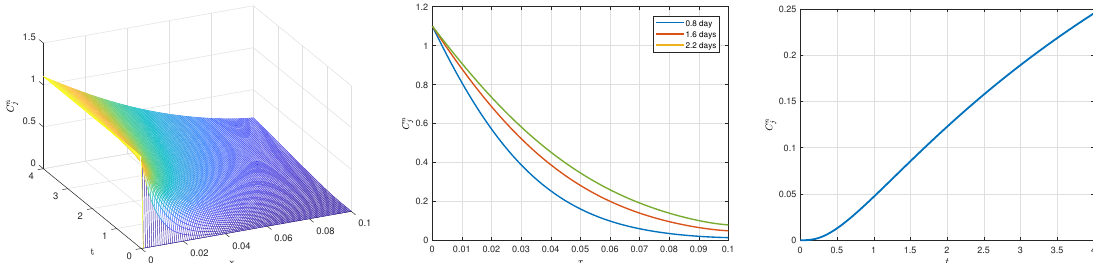
Figure 6. Numerical simulations obtained with α = 0.5. Left frame: H 2 concentration along axial direction at different space and time; Middle frame: the concentration profile of 0.8, 1.6, and 2.2 days; Right frame: H 2 profile at point x = 0.08 of the Zr 2 Fe bed.